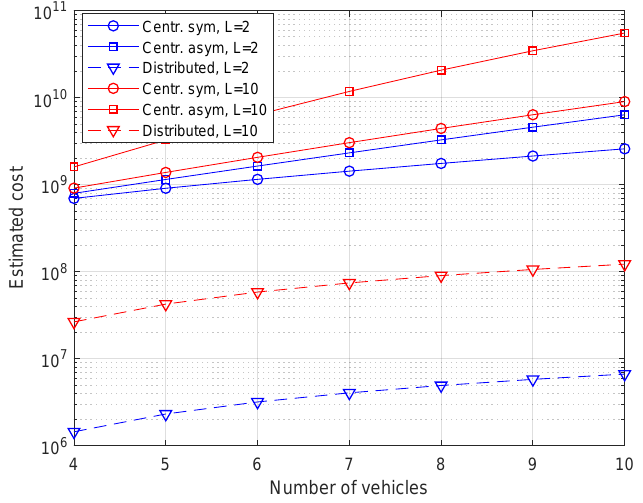
Figure 8. Estimated cost versus number of vehicles for the centralized (symmetric and asymmetric) and distributed REM reconstruction schemes with L = 2 m and L = 10